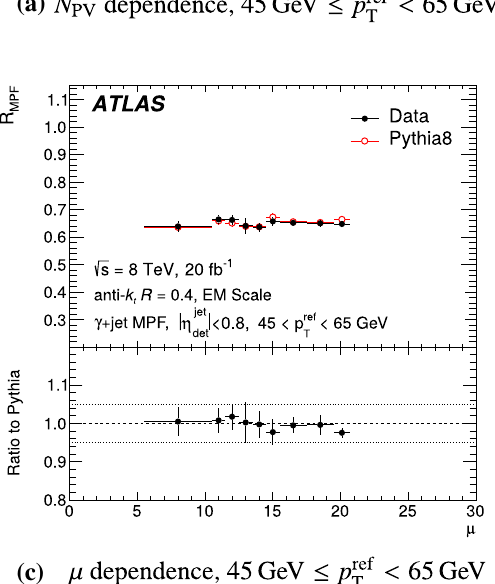
Fig. 25 MPF response R MPF in γ +jet events for jets calibrated at the EM scale for both data (black filled circles) and MC simula- tion (red empty circles), as a function of a , b N PV and c , d μ for